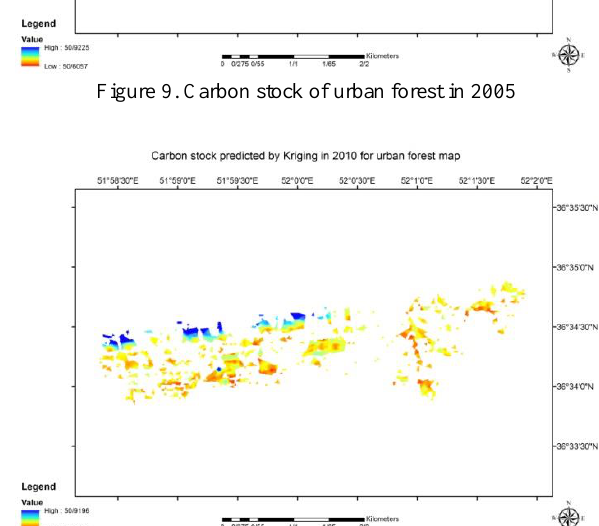
Figure 10. Carbon stock of urban forest in 2010